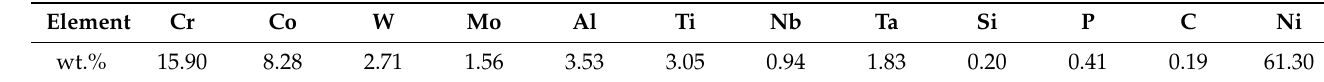
Table 1. Chemical composition of K438.